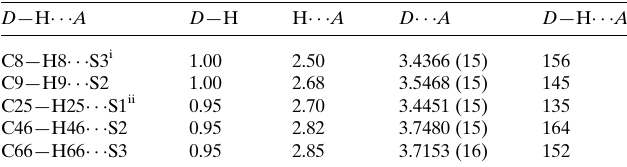
Table 2 Hydrogen-bond geometry (A˚ , (cid:4) ).